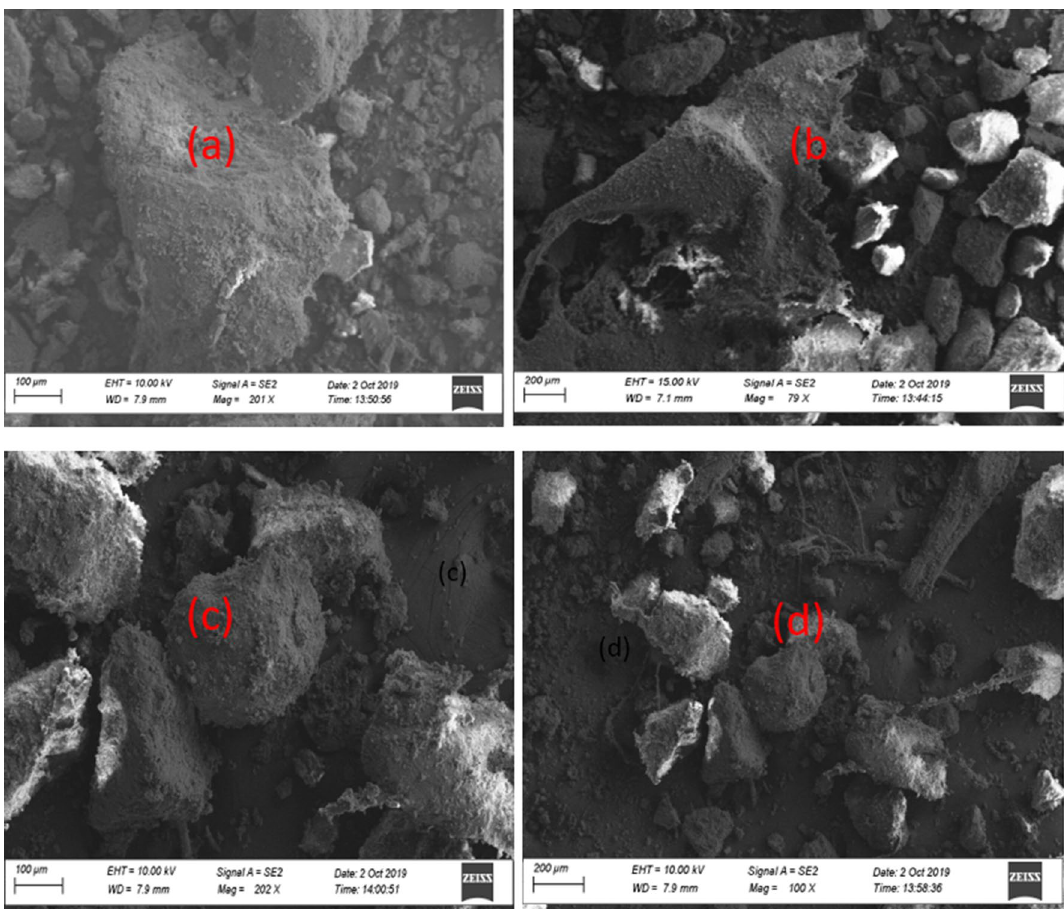
Figure 2. microscopic observation of raw sewage sludge D: ( a ) and ( b ), S: ( c ) and ( d